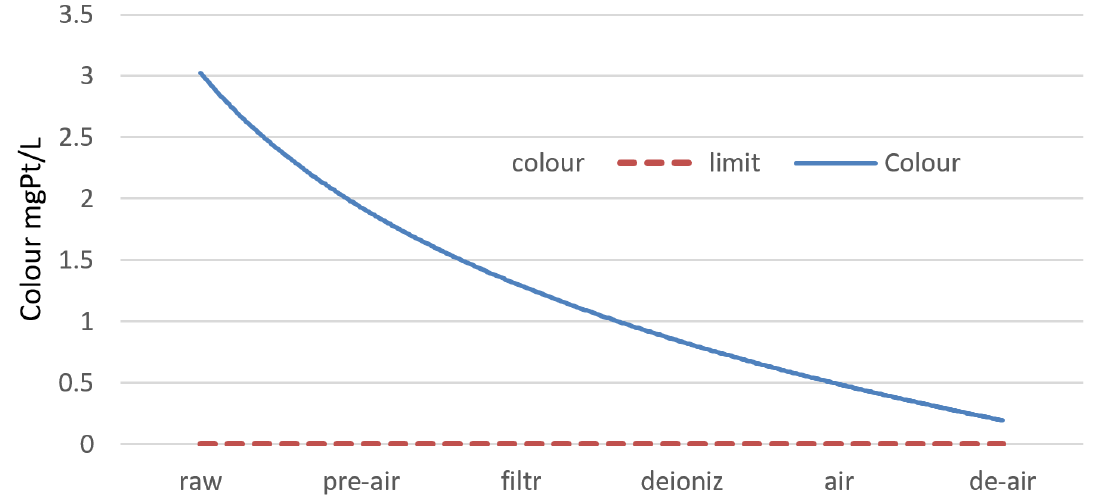
Figure 5. Changes of water colour. Source: Own elaboration.